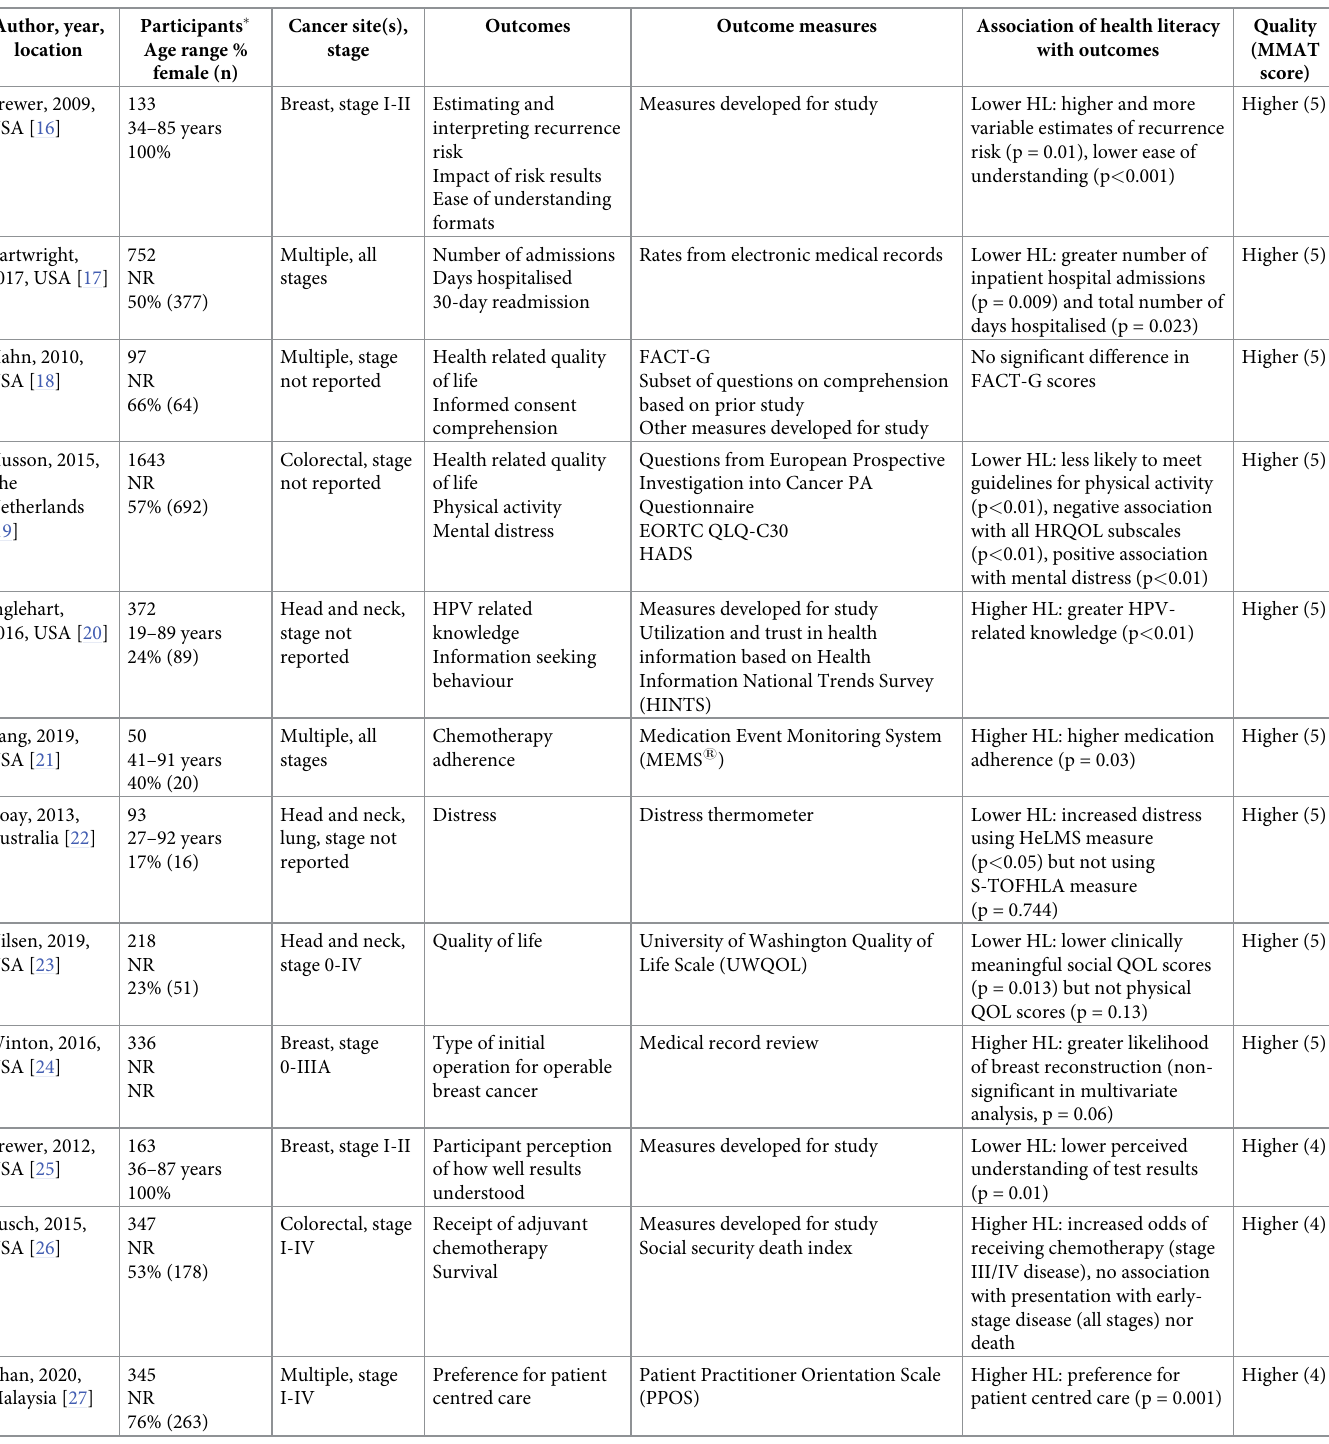
Table 1. Included papers reporting associations with health literacy ( N =